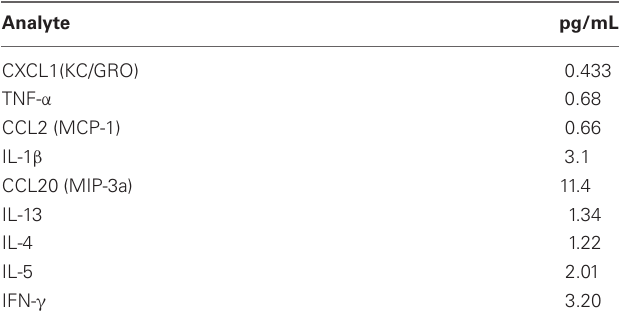
Table 1 | Lower limits of detection at 95% confidence. Analyte